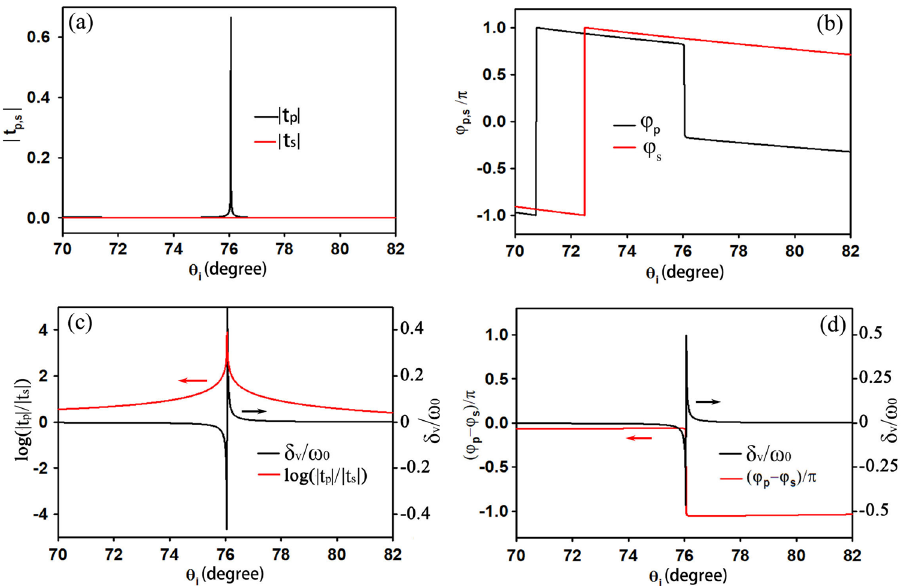
Figure 8. Amplitudes (a) and phase distributions (b) of the Fresnel transmission coefficients for a ROTE structure, (c) is the transverse shift and transmission ratio near the Brewster angle, (d) is the transverse shift and phase difference distributions near the Brewster angle, where the incident light is a V-polarized beam with a beam waist of 50λ.The structural and material parameters of the ROTE structure are the same in Ref. 10 except h 3 = 100